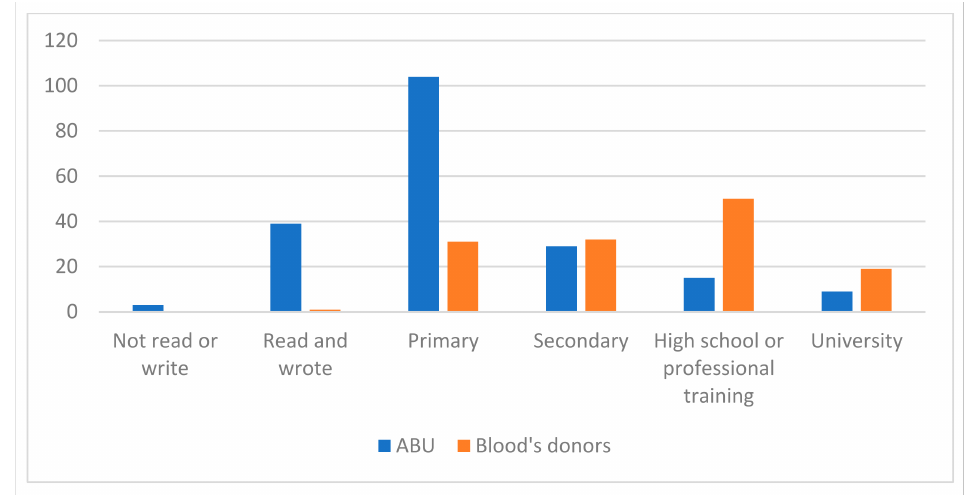
Figure 3. Comparison of the study level for both groups (ABU and blood